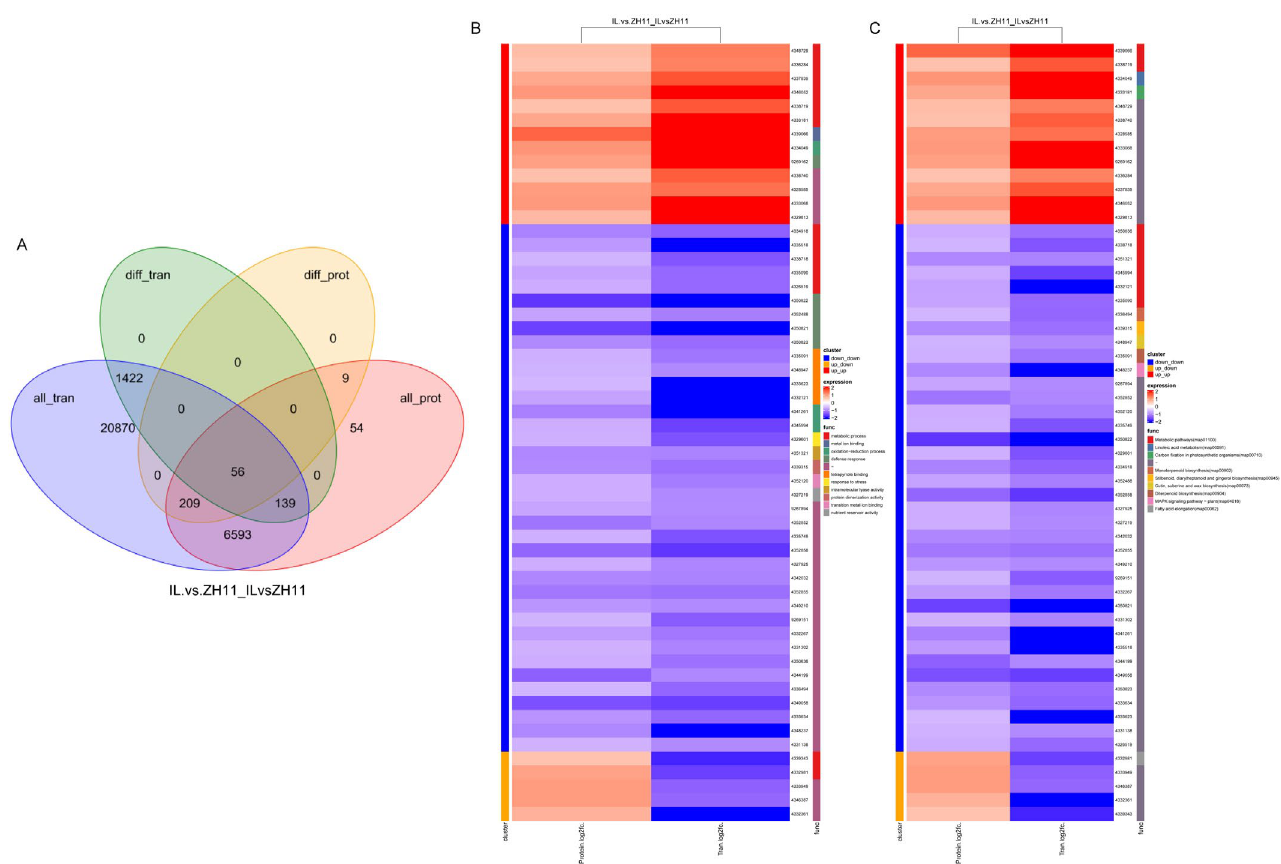
Figure 4. Association analysis of RNA−seq and proteomics. ( A ) Overlap between transcript and protein. ( B ) Go enrichment analysis of the heat map of the RNA−seq and proteomics. ( C ) KEGG enrichment analysis of the heat map of the RNA−seq and proteomics.